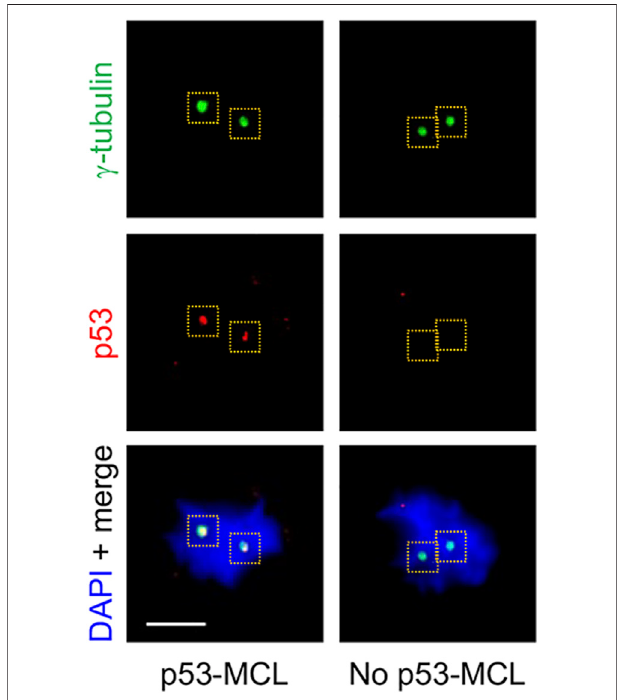
FIGURE 6 | p53-MCL in AT1-54000 and AT1-54001 cell lines. Representative immuno fl uorescence images of p53-MCL in LCLs. In particular, the AT1-54000 non-treated cells are shown. Cells were stained for p53 (red) and y-tubulin (green) for centrosome identi fi cation (yellow dashed squares). DNA(blue) wasstained with DAPI. p53-MCL wasevaluated by counting mitotic cells showing (p53-MCL) or not (no p53-MCL) p53- centrosome colocalization. Scale bar (cid:2) 5 µm, × 100